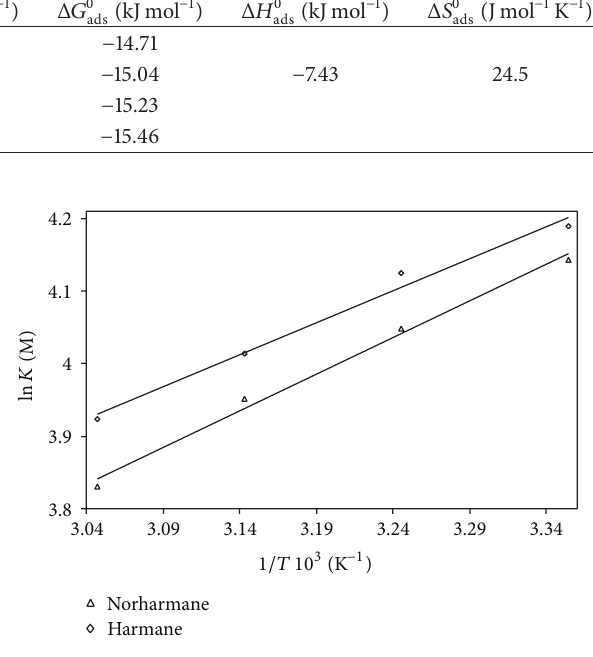
Figure 20: Van’t Hoff plots for the C38 steel/indoles/1M HCl system evaluated from